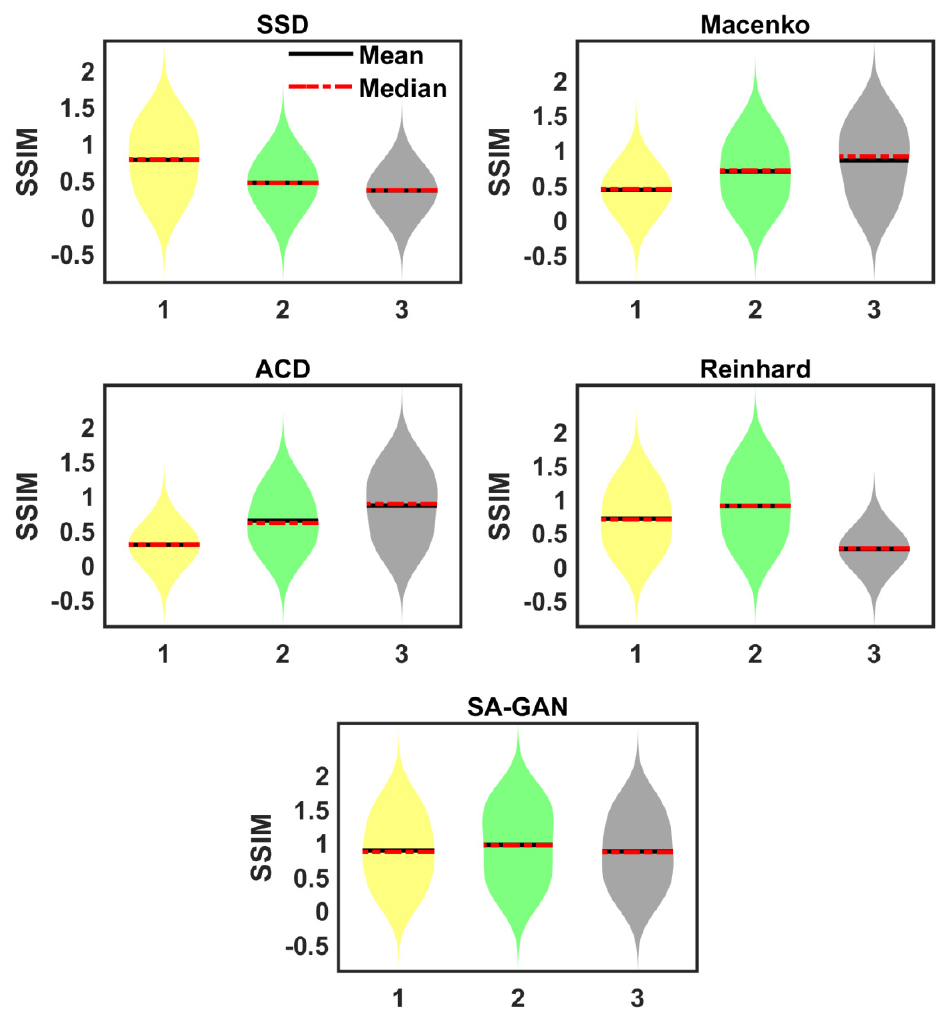
Figure 4. Violin plots of prior proposed methods show the variation of SSIM metric due to the improper selection of target images (‘1’, ‘2’, ‘3’ in x -axis represents the three different target images). The results are evaluated on ICIAR 2018 dataset [34].